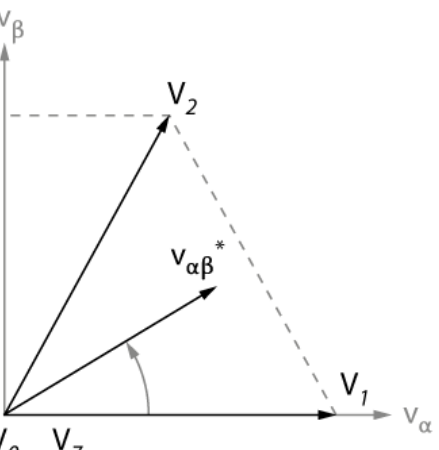
Figure 13. Synthesis of a reference space vector V ∗ V 2 , and the zero vectors V 0 and V 7 .